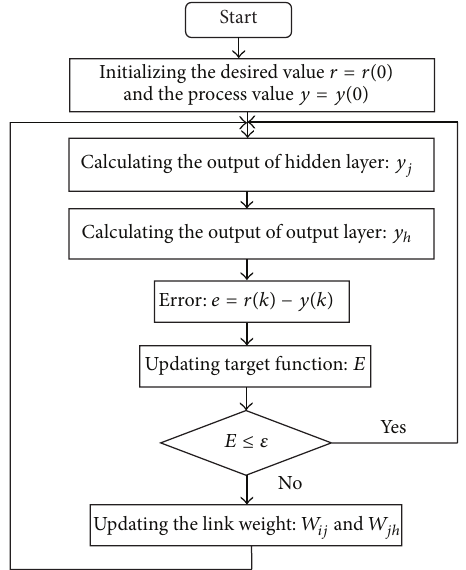
Figure 5: Flow chart of 3-layer BP NN working